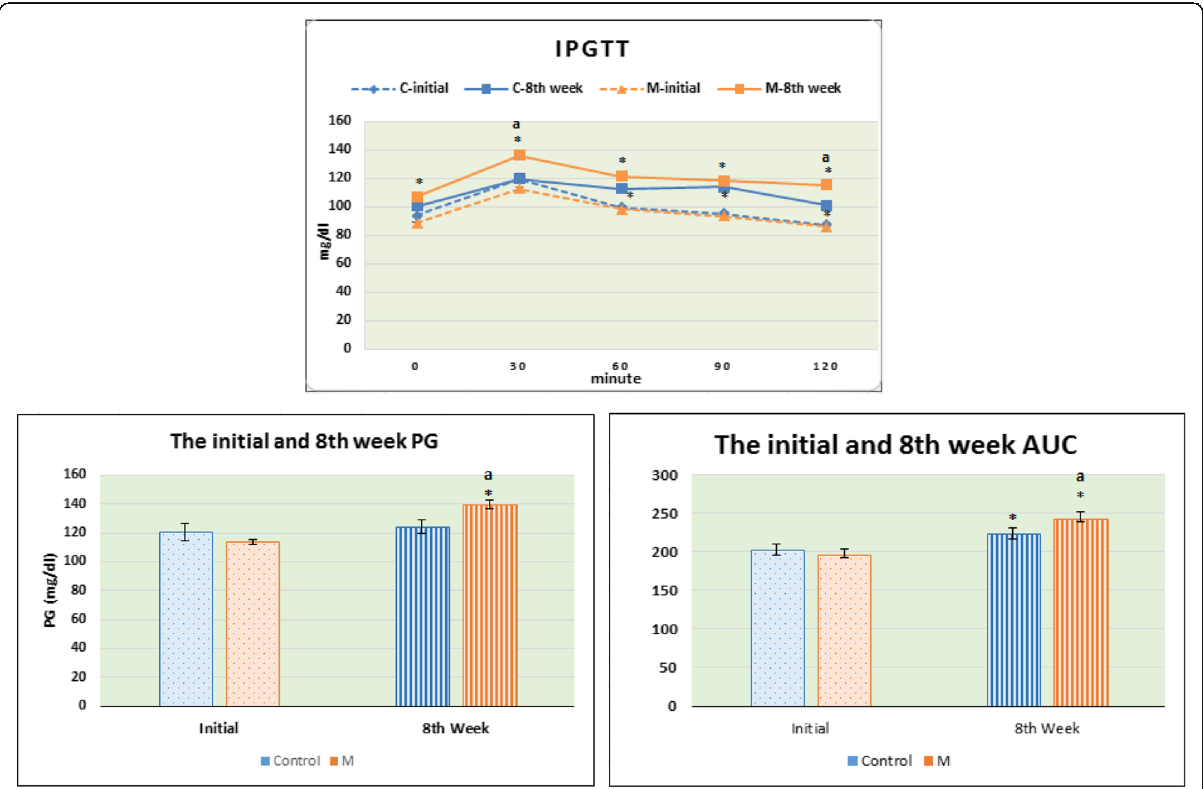
Fig. 1 The initial and 8th week glucose homeostasis parameters in control and metabolic syndrome groups. M metabolic syndrome group, IPGTT intraperitoneal glucose tolerance test, PG peak glycemia, AUC area under the curve. Data are expressed as mean ± SEM. * Significance from initial value, by Student ’ s “ t ” test for paired data, at P ≤ 0.05. a: Significance from control group, by Student ’ s “ t ” test for un-paired data, at P ≤